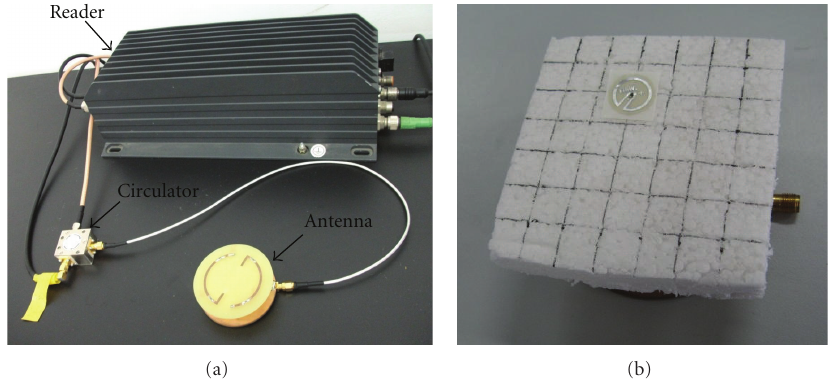
Figure 5: The configuration of interrogation range measurement: (a) Measurement scenario: reader antenna, circulator, and reader which is connected with computer. (b) Foam board and tag is positioned above the